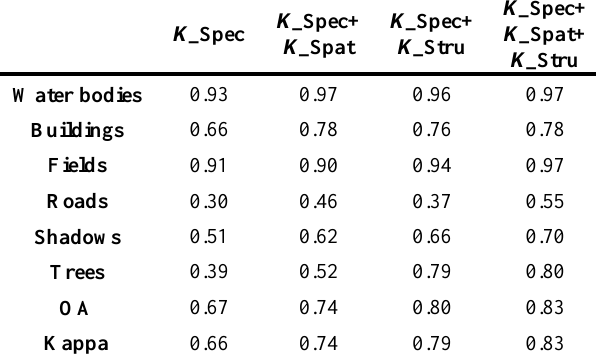
Table 2. The accuracy of different geo-object classes using different methods in our experiments, and overall accuracy and kappa coefficient as